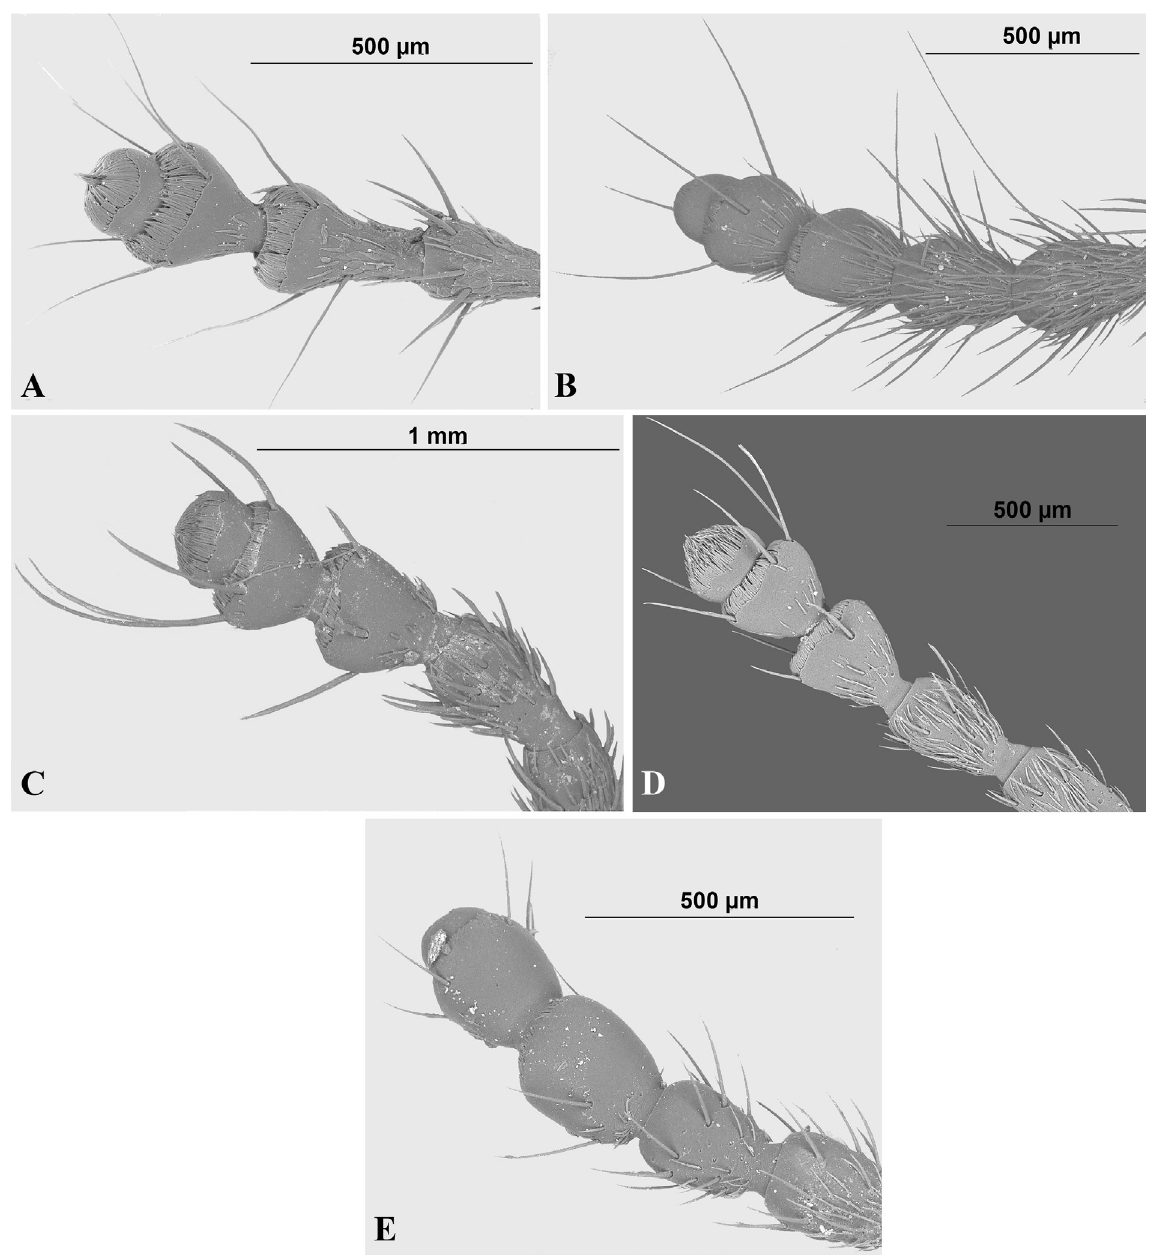
Fig. 24. Apical antennomeres of different taxa of Pimeliini. A . Habrobates vernalis Semenov, 1903 ♂, paralectotype (ZIN). B . Przewalskia dilatata (Reitter, 1887), ♂. C . Mantichorula semenowi Reitter, 1889, ♂ (ZIN). D . Platyope leucogramma (Pallas, 1773), ♀. E . Earophanta serrata (Semenov, 1893), ♂